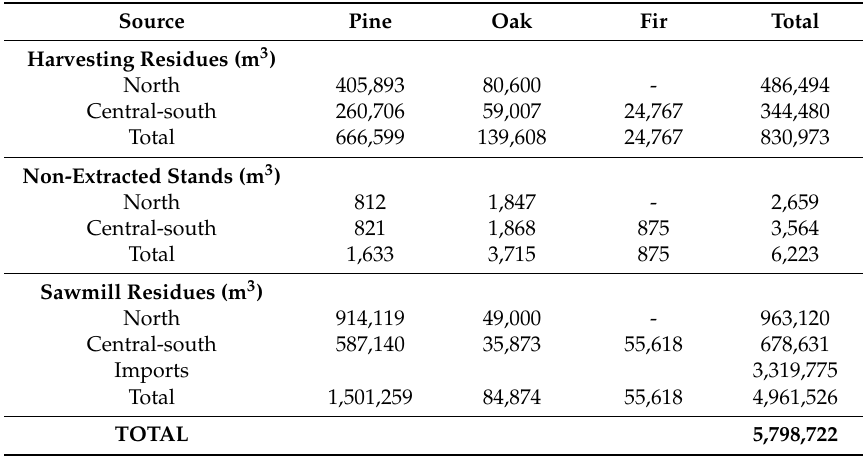
Table 5. Technical availability of woody biomass for 2013 constrained by soil degradation, slope percentage and mechanization level (m 3 ).